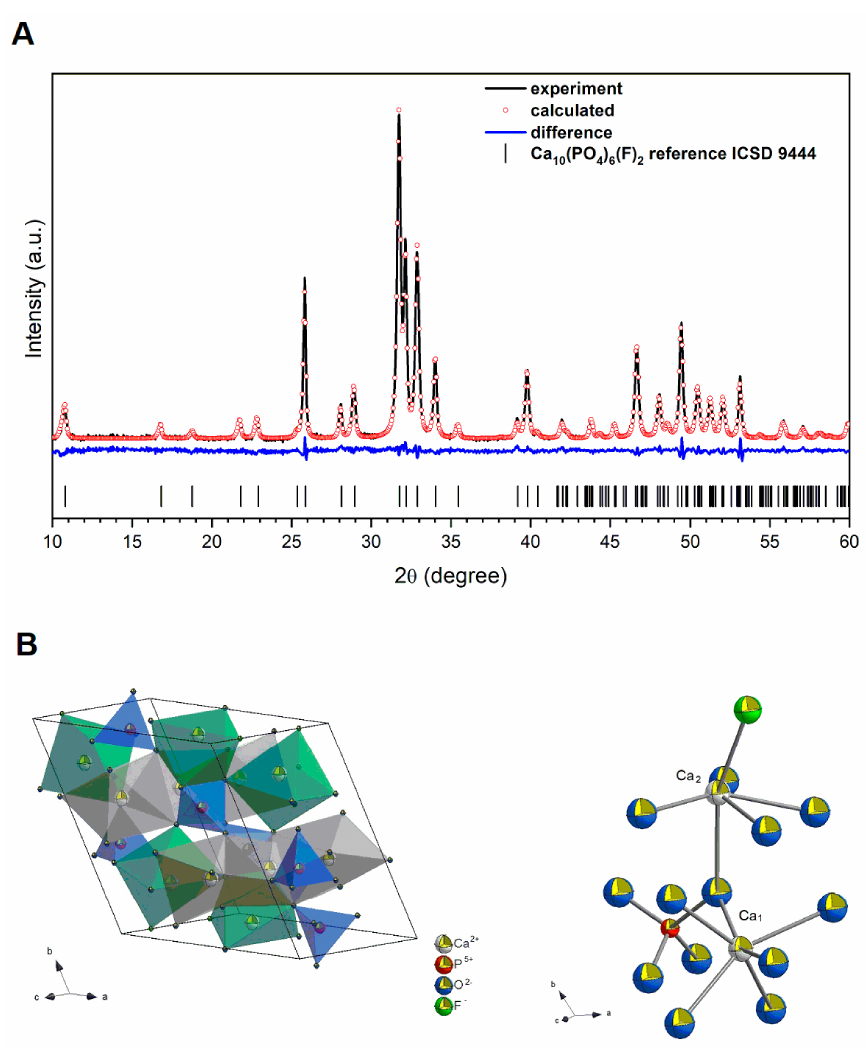
Figure 1. XRD pattern (back line) and result of the Rietveld analysis of the Ca 10 (PO 4 ) 6 (F) 2 nanoparti- cles annealed at 450 °C ( A ); projection of the obtained Ca 10 (PO 4 ) 6 F 2 unit cell and indications of the Ca 1 and Ca 2 crystallographic positions ( B ).